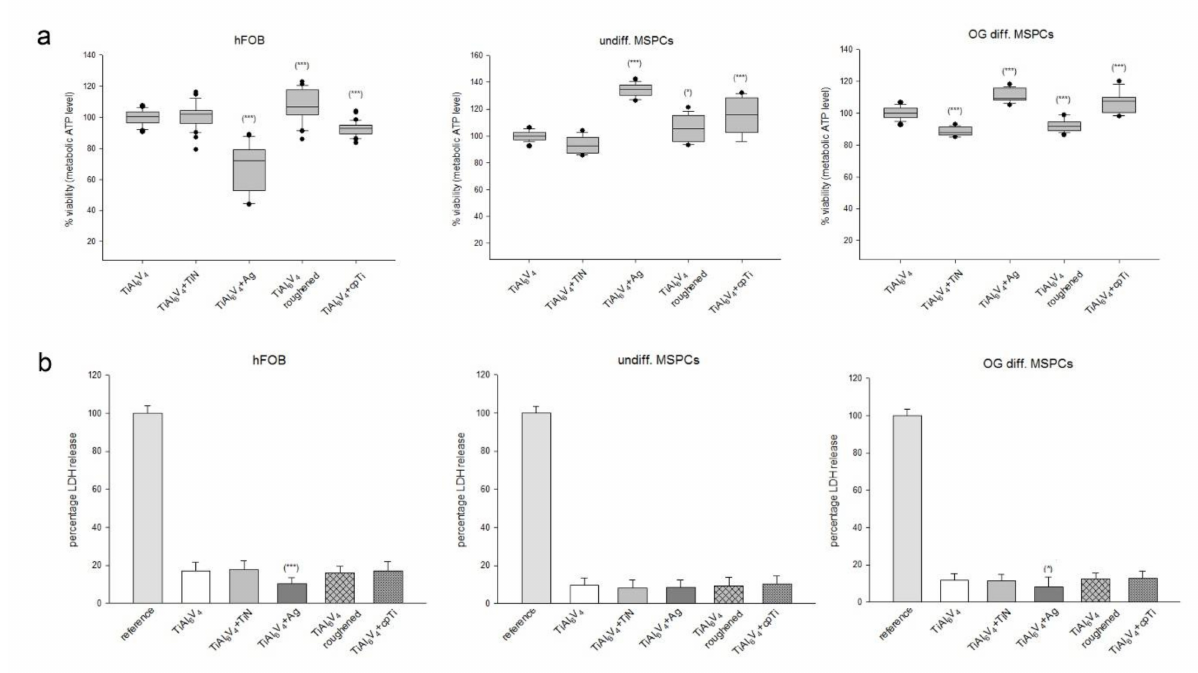
Figure 3. The influence of TiAl 6 V 4 surface modifications on viability and cytotoxicity. ( a ) The cell viability of human osteoblasts, undifferentiated MSPCs, and osteogenic differentiated (OG) MSPCs on uncoated TiAl 6 V 4 , titanium nitride (TiN) coated, silver coated (Ag), a roughened surface, and a pure titanium coated (cpTi) surface was represented with box plots (mean ± SD; n = 8; measured in quadruplicate). Statistical significances are defined as follows: *** p < 0.001; ** p < 0.01; * p < 0.05. ( b ) No significant changes were seen in the evaluation of cytotoxicity (mean ± SD; n = 6; measured in